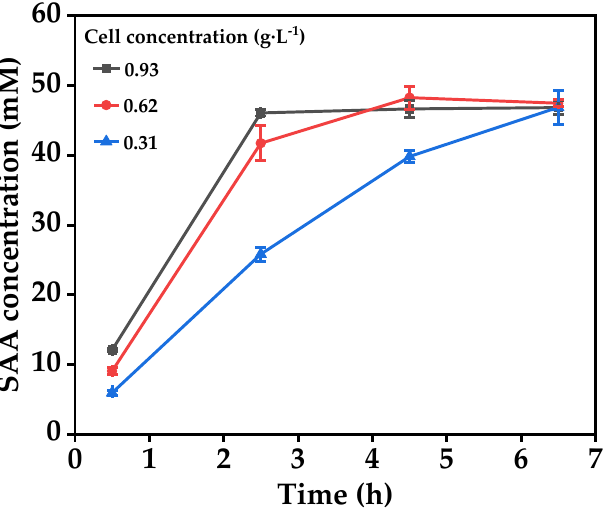
Figure 7. Effect of permeabilized BL21(DE3)-pETDuet- dldh - fdh cell concentration on SAA.